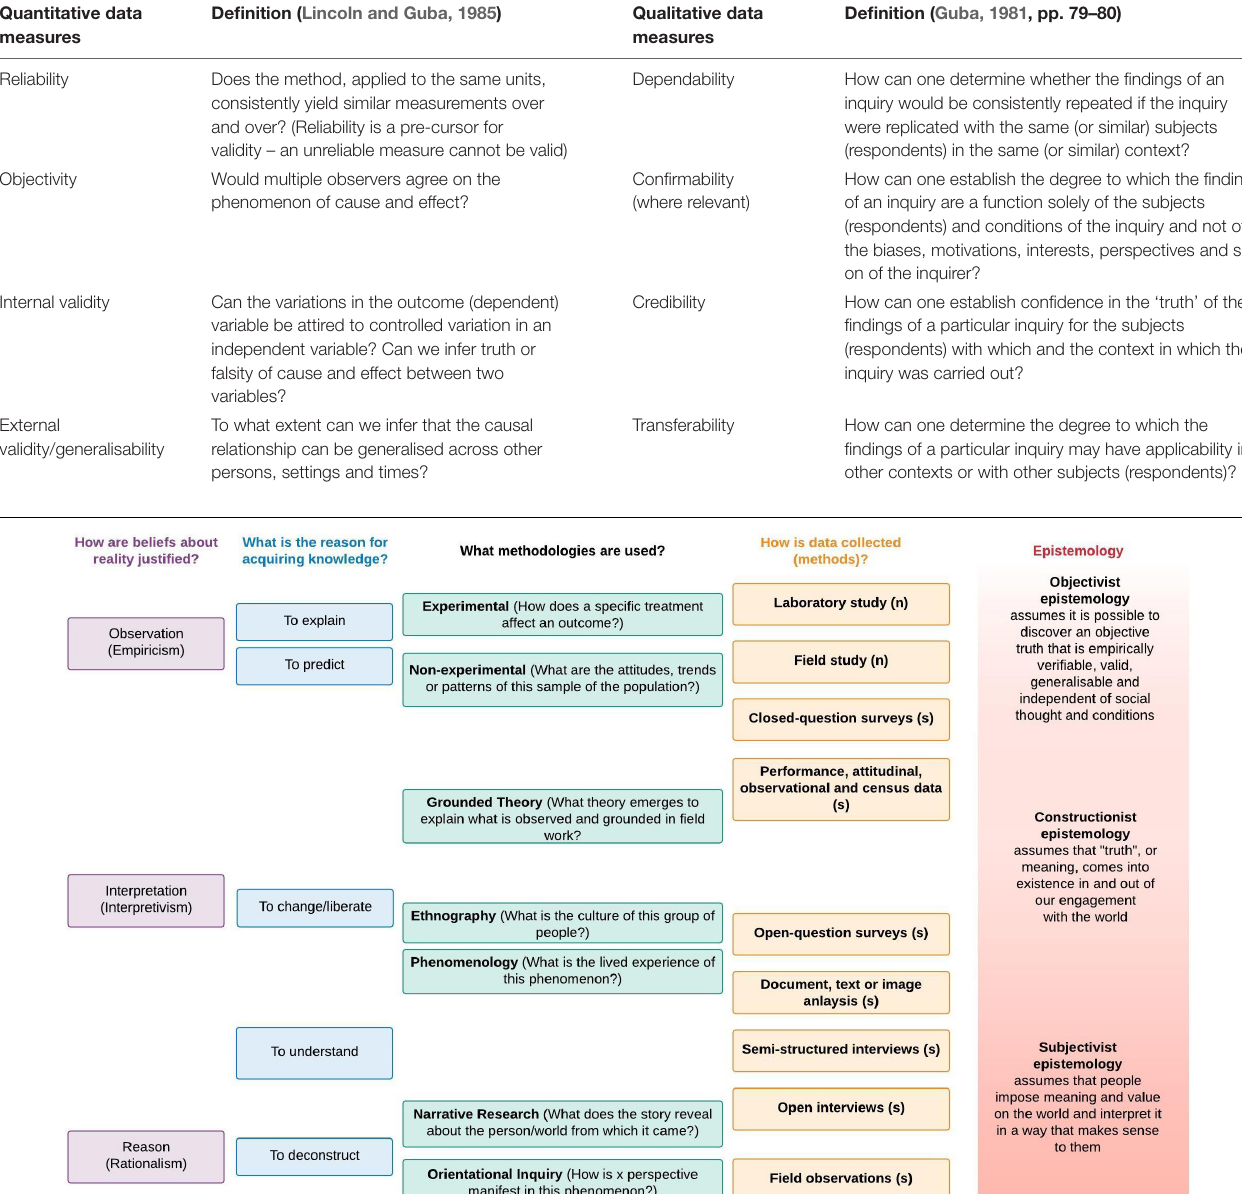
TABLE 1 | Measures and definitions of research